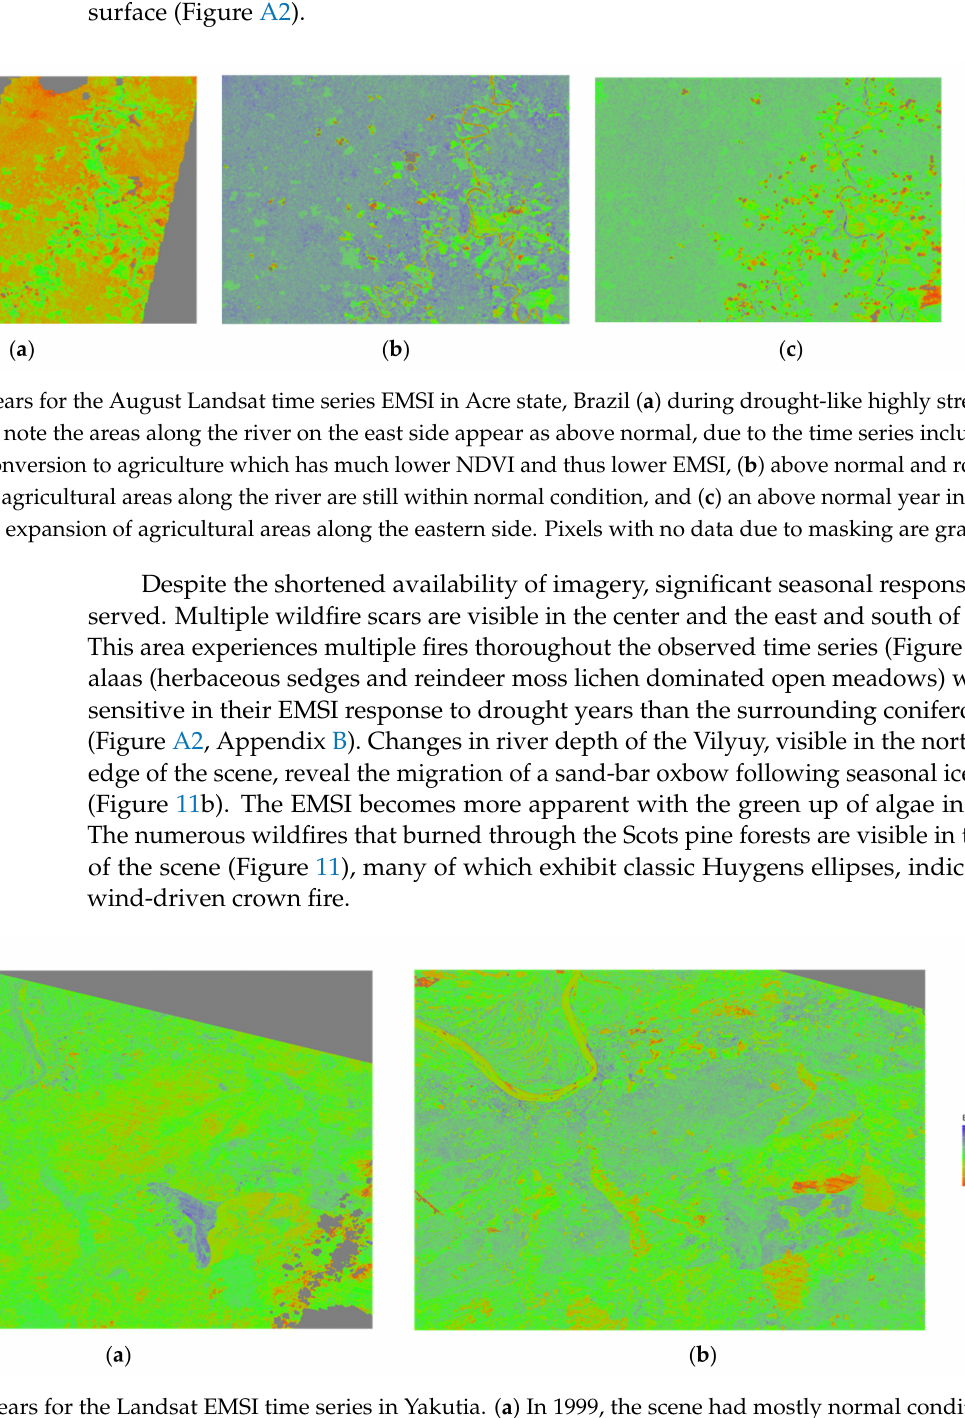
Figure 11. Select years for the Landsat EMSI time series in Yakutia. ( a ) In 1999, the scene had mostly normal conditions. Areas which burned in 2003 appear as above average for the reference time series. ( b ) By 2019, the scene has undergone many repeated wildfires, with the most recent fires appearing as deeply disturbed (red), while the previous burned area has rebounded and is again recovering. The Viluly river on the northwest side of the scene is visible as a large oxbow where the village of Verkhneviliuisk is located along the south